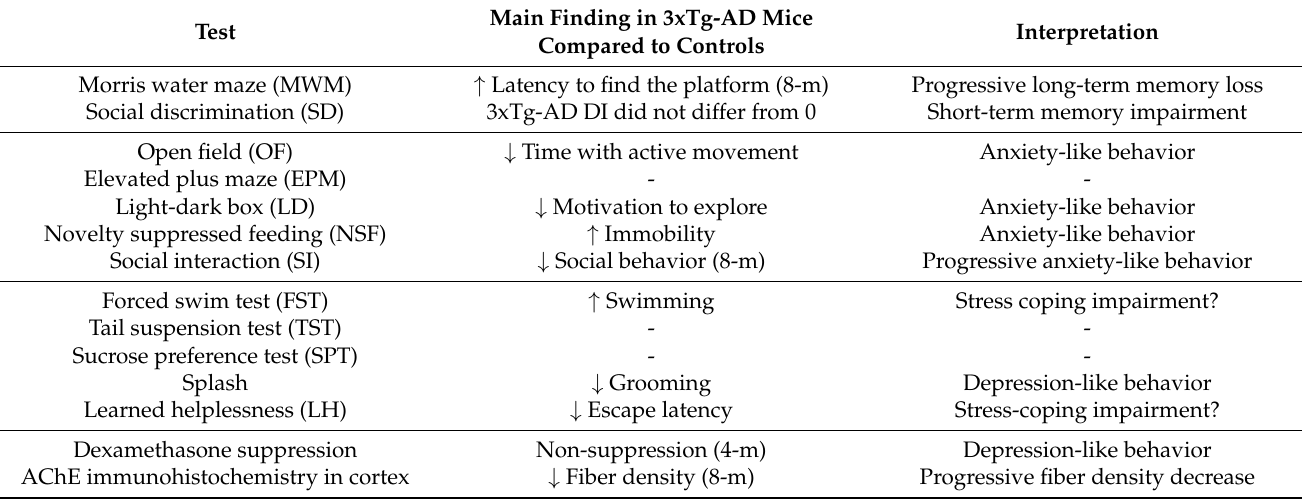
Table 1. Summary and interpretation of results. Arrows are used to indicate significant increase ( ↑ ) or decrease ( ↓ ) in a given parameter in 3xTg-AD animals compared to controls. Abbreviation: